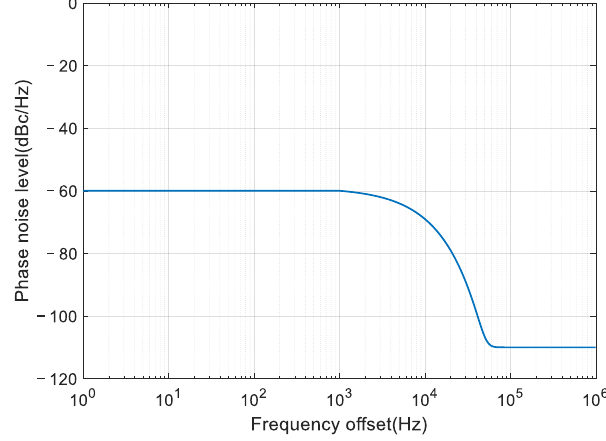
Figure 4. The power spectrum of phase noise when a = 6.